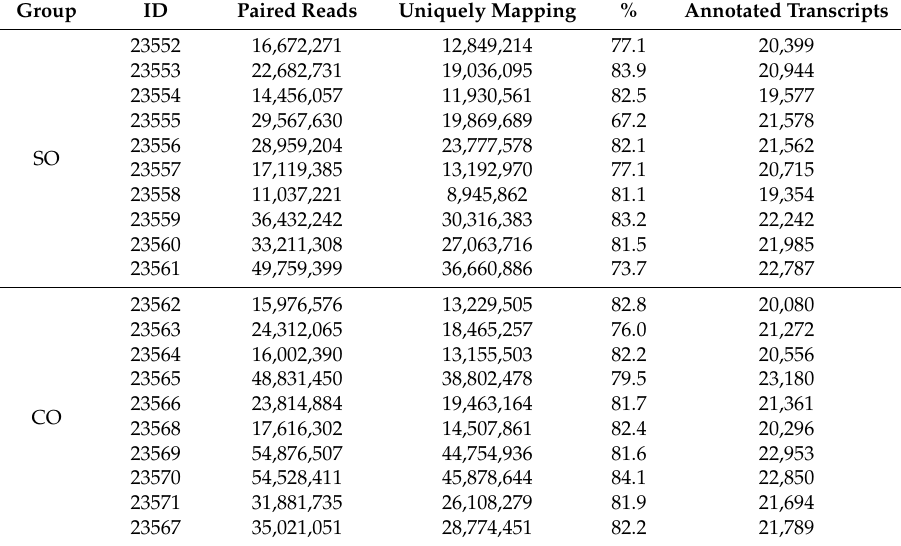
Table 3. Next-generation sequencing